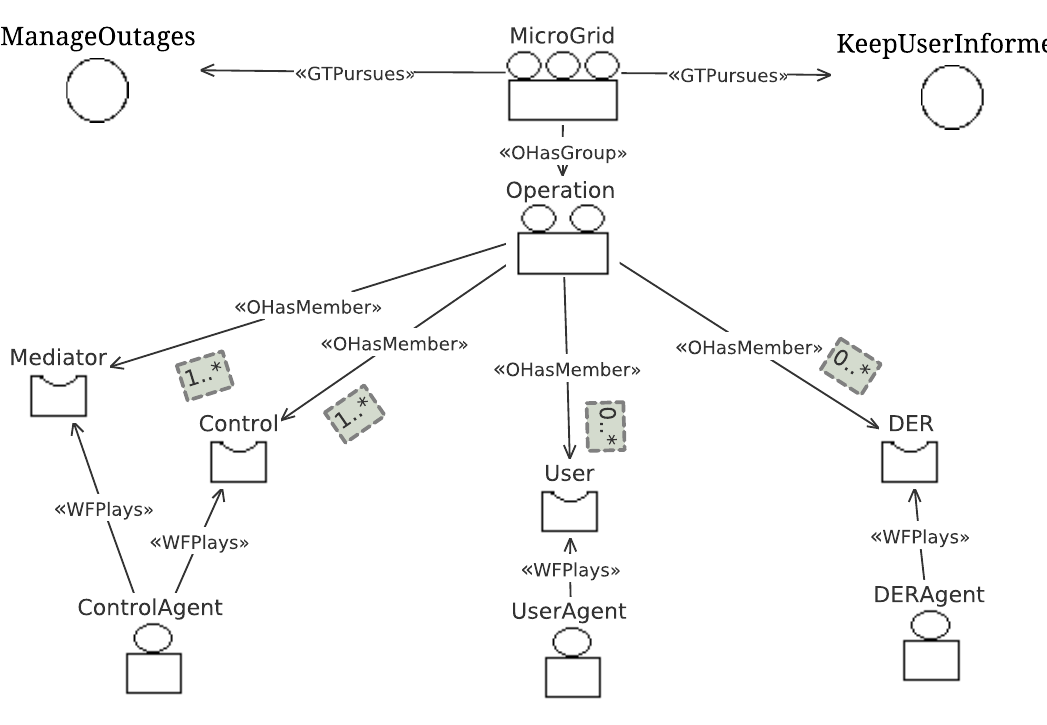
Figure 2. Agents of I2DAPS associated to an organization. (DER means “Distributed Energy